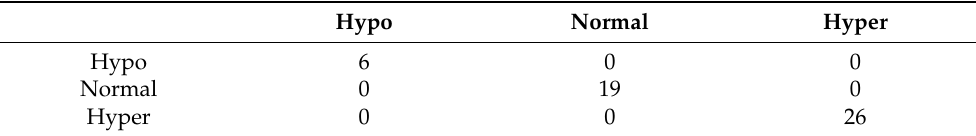
Table 4. Confusion matrix of lumbar lordosis assessment through corners of vertebra. There are no failure cases in any of the predicted classes due to less error between ground truth and predicted angles values.